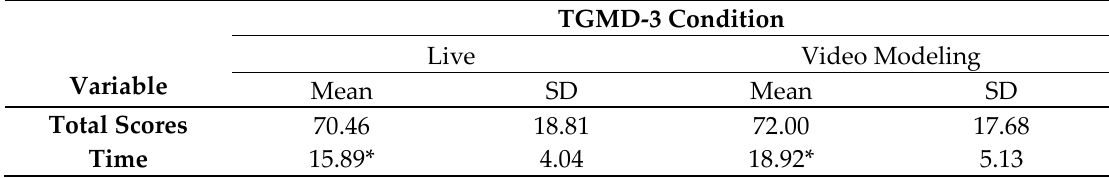
Table 1. Means and standard deviations of total gross motor scores and assessment time by